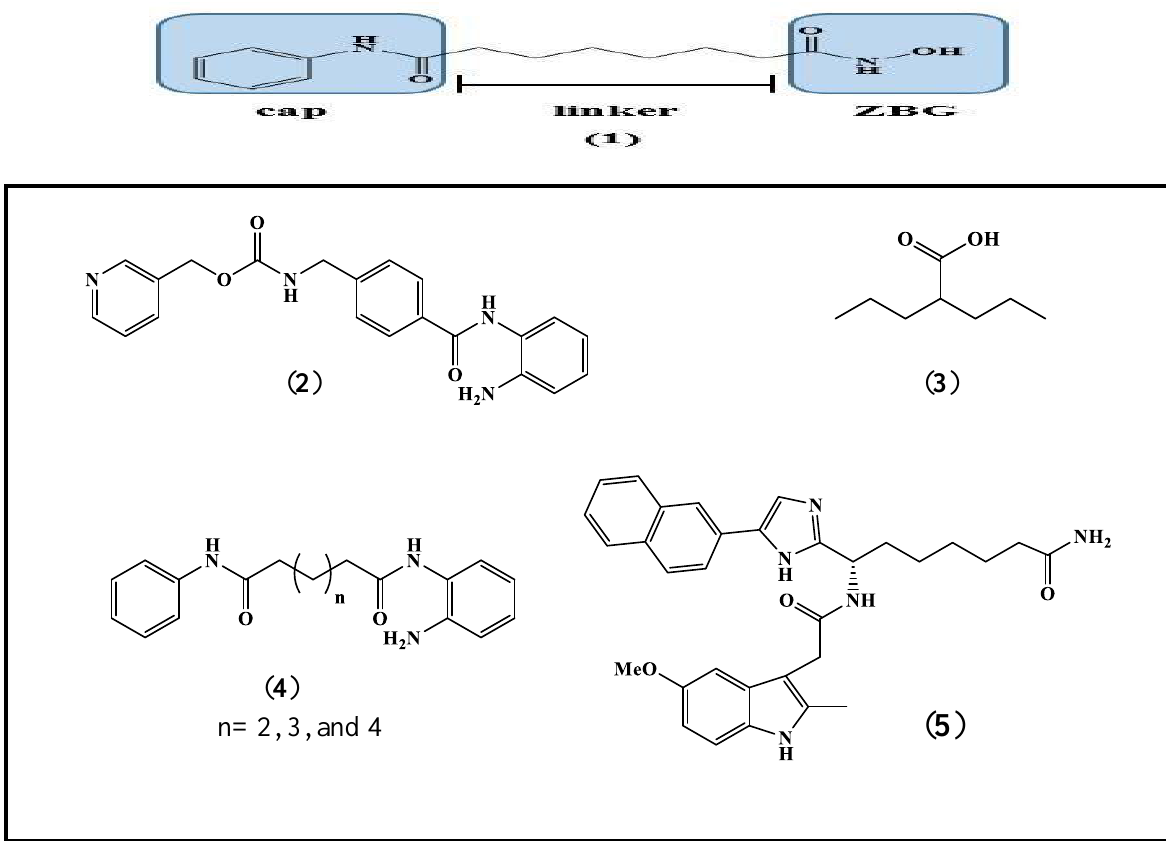
Figure2. Examples of HDAIs with different ZBGs Here, we wish to describe the synthesis of the small and simple primary amide molecules 6 and 7 that fulfill the three requirements for zinc-dependent HDAC